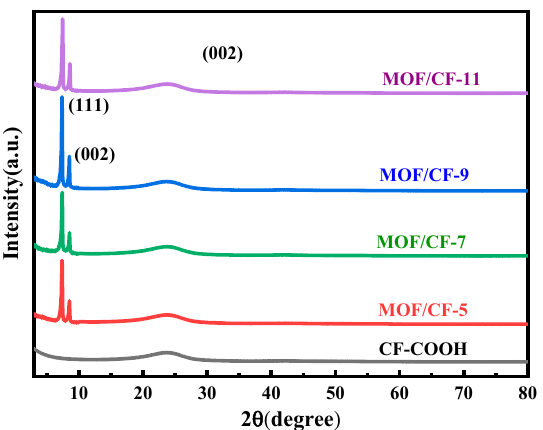
Figure 4. XRD patterns of MOF/CF at different acid concentrations.